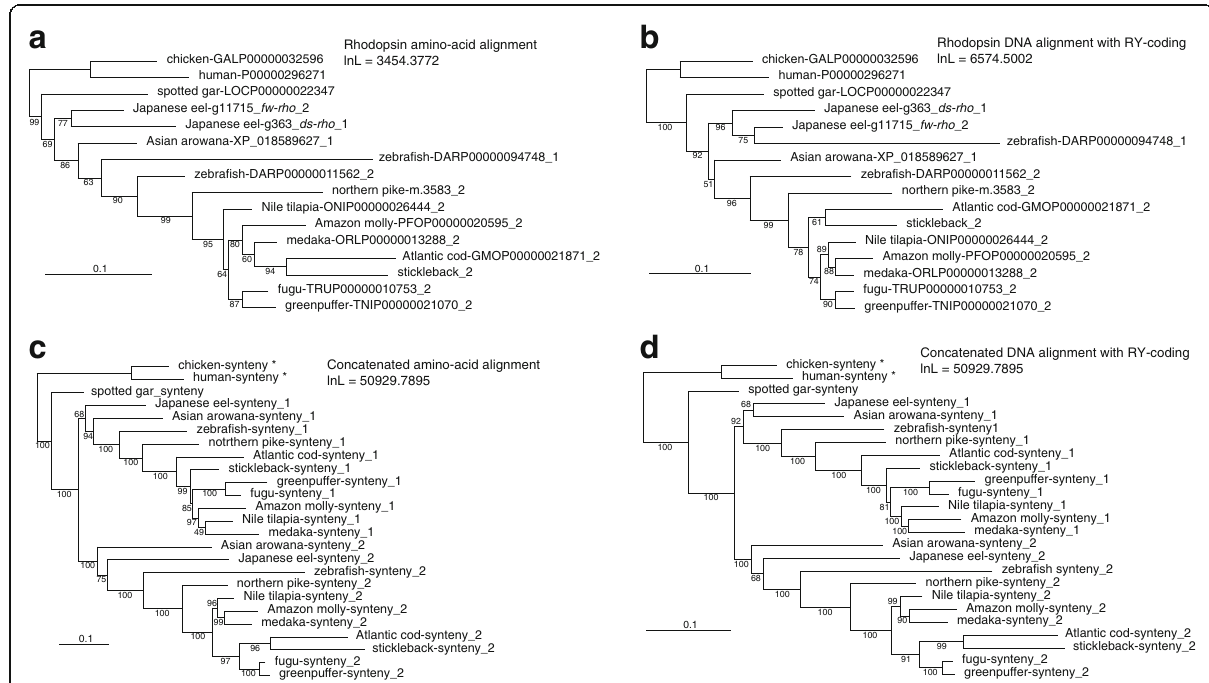
Fig. 4 Phylogenetic treesPhylogenetic relationships among rho ( a , b ) and concatenated synteny ( c , d ) sequences. Amino acid ( a , c ) and RY-coded DNA ( b , d ) sequence-based trees are shown. Numbers attached to teleostean gene IDs denote syntenies on which genes are encoded. Numbers beside branches indicate local bootstrap [66] support (%) of each branch. * Chicken and human rho sequences of synteny data are from a remote